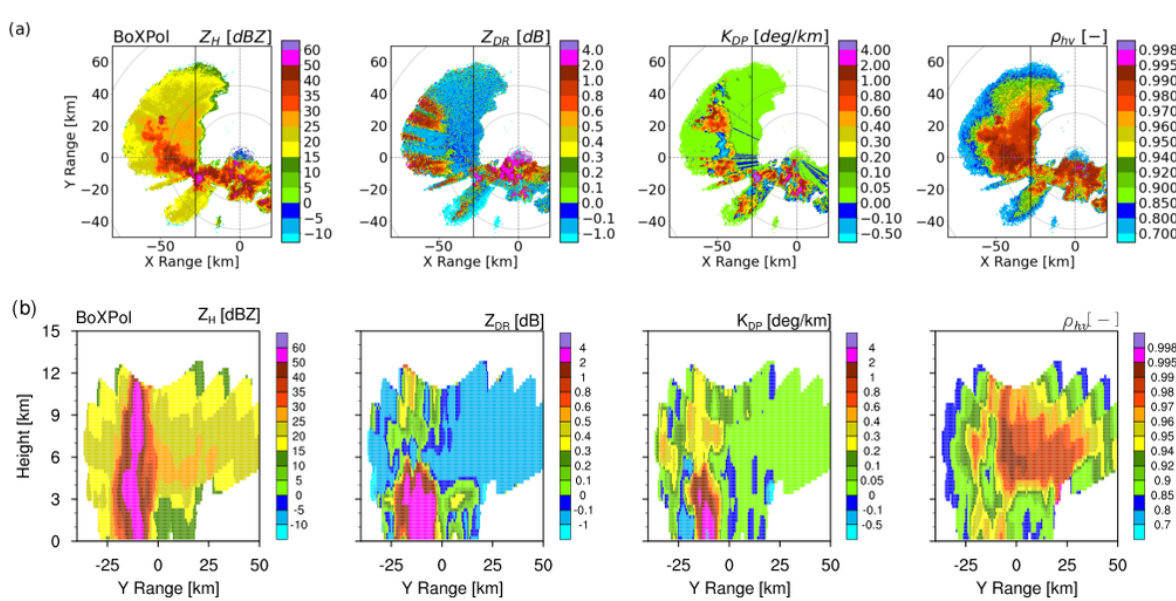
Figure 9. (a) PPI plots of horizontal reflectivity, differential reflectivity, specific differential phase and cross-correlation coefficient at 8.2 ◦ elevation measured by BoXPol on 6 July 2017 at 14:00UTC. The dotted grey circles represent slant ranges for the chosen elevation angle, associated with a height of 1km (lower levels), 4km (melting layer), 6.5km (upper levels) and 13km. (b) Cross section of the same polari- metric variables from the gridded data. The vertical solid black line along the Y range in panel (a) indicates the location of cross-section